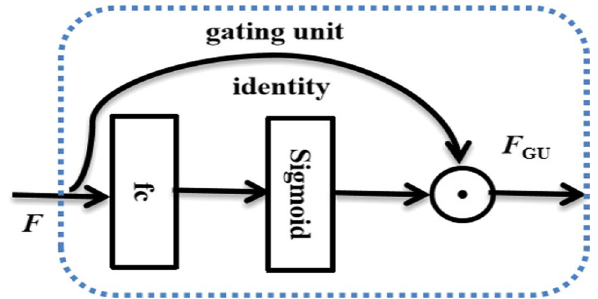
Fig. 3 The structure of GU